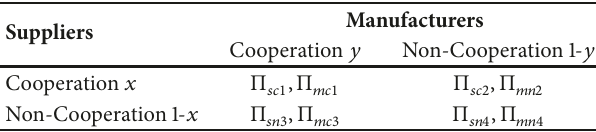
Table 1: The payoff matrix of game between suppliers and manufac-